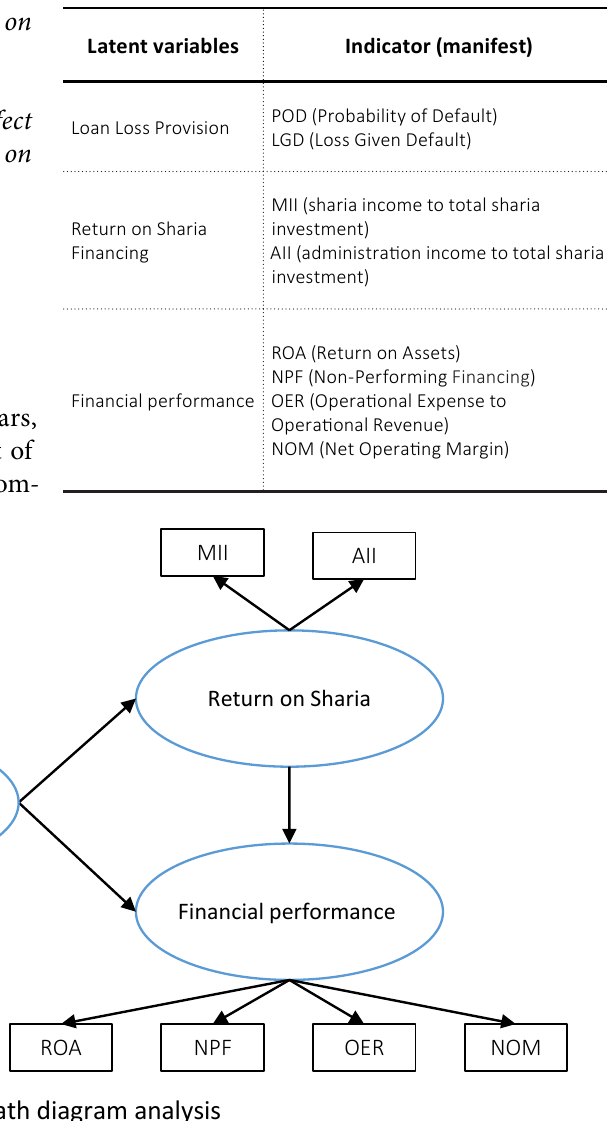
Table 1. Latent variables and an indicator (manifest)